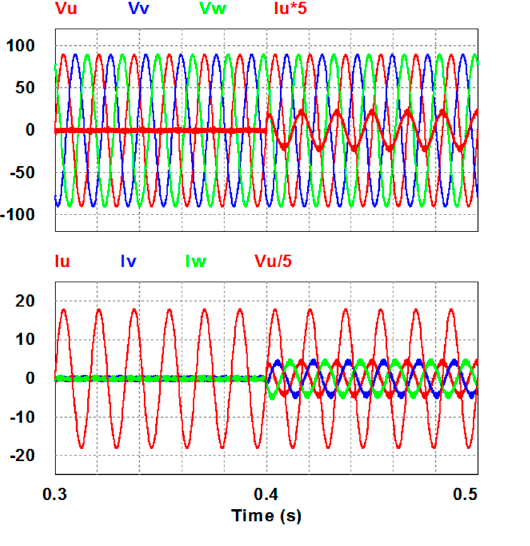
Figure 18. Case 2 simulation result: three-phase voltages and currents.